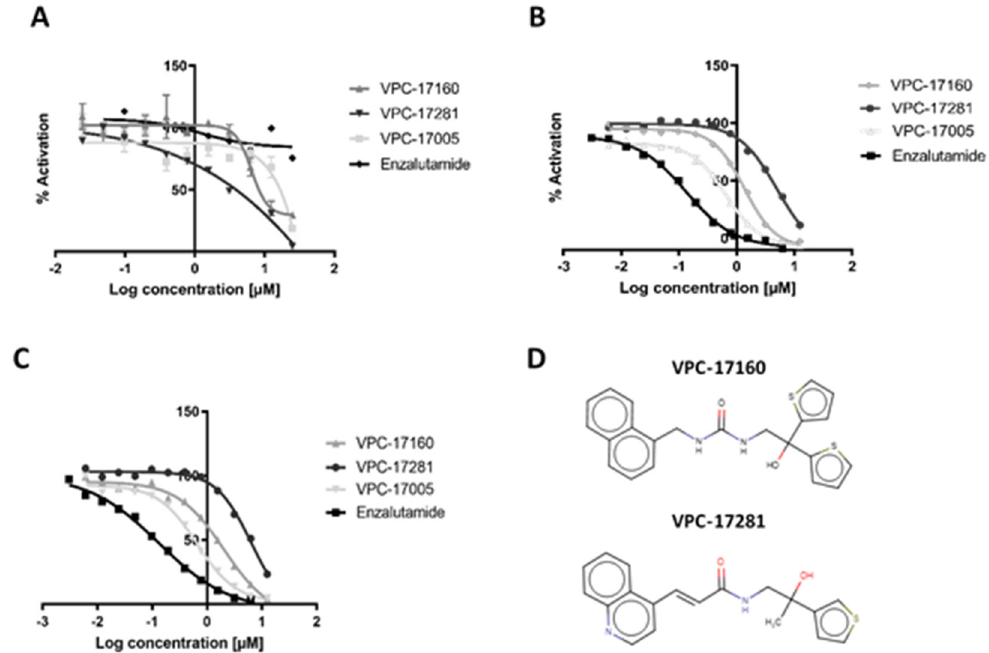
Figure 2. In vitro inhibition of AR-V7 and AR-FL transcription. ( A ) Dose-response curve illustrating the inhibition of AR-V7 in doxycycline-inducible AR-V7 construct with ARR3tk-nanoLuciferase reporter, ( B ) Inhibition of AR transcriptional activity in LNCaP-eGFP cells, ( C ) The inhibition of AR-mediated prostate-specific antigen (PSA) expression in LNCaP cells. Data points represent a pool of triplicates for each concentration. ( D ) Chemical structure of VPC-17160 and VPC-17281.